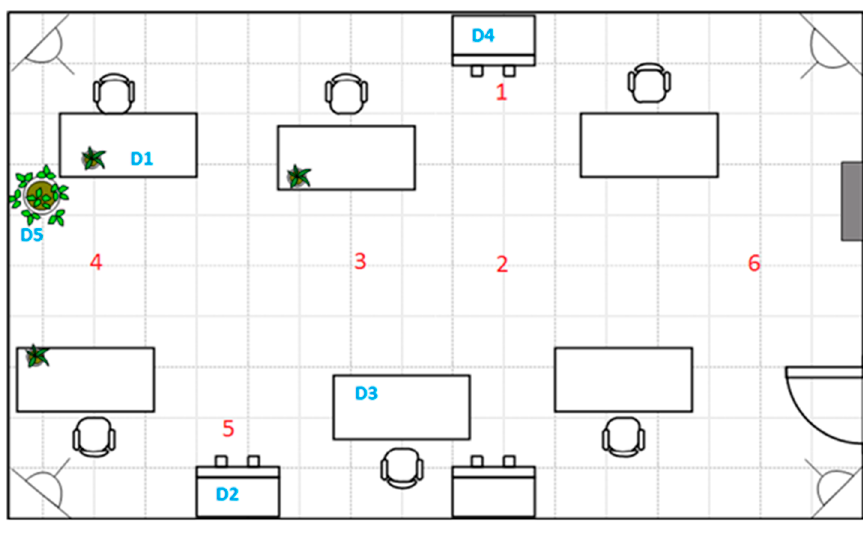
Figure 10. Standard deviation of the samples taken for the y-coordinate. Another test was performed in the facilities of LQT comparing the accuracy performance using one and two tags. Six different points of an office, shown in Figure 11, were selected to evaluate the